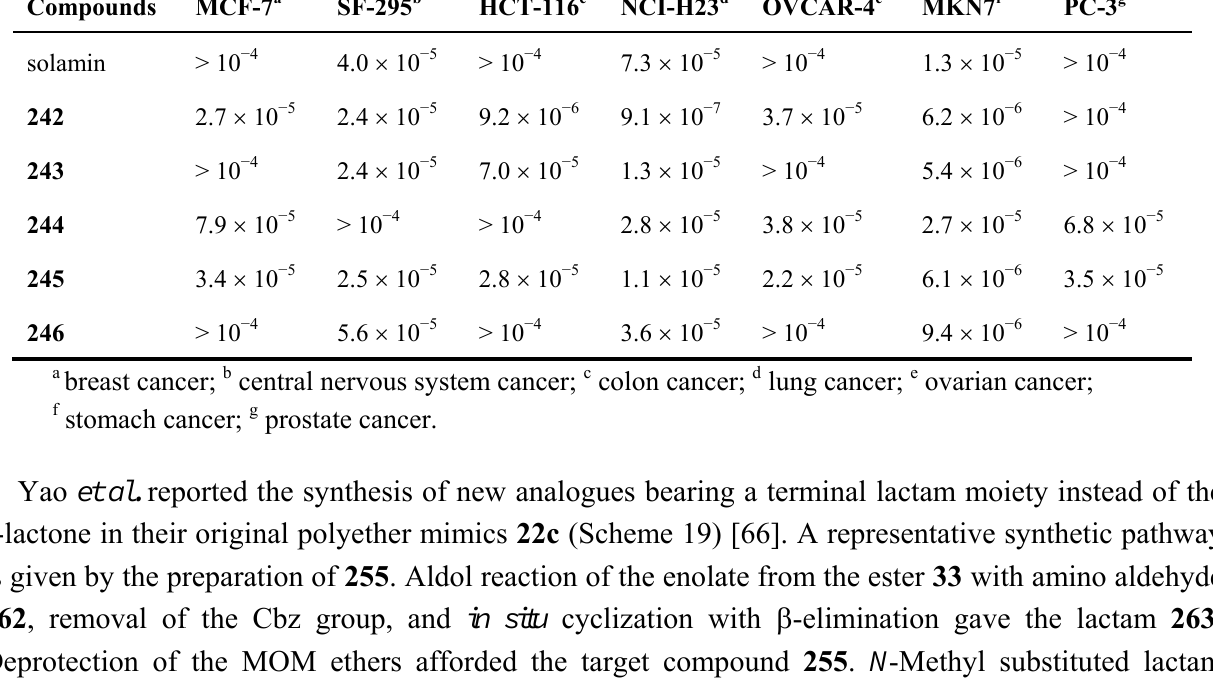
Table 18. Selected GI (M) values of heterocyclic analogues against human cancer cell lines. 50 Compounds